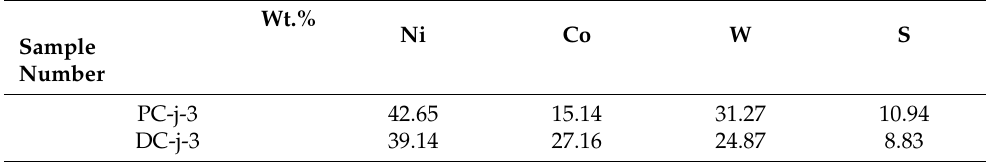
Table 5. Elemental content of the Ni-Co/WS 2 nanocomposite coatings prepared by PC and DC electrodeposition.